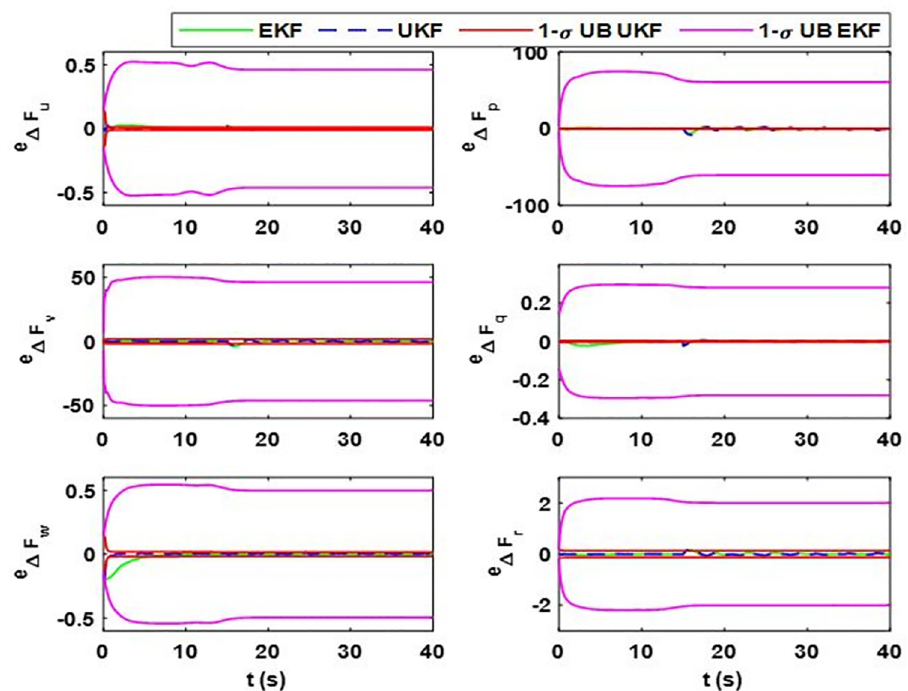
Fig 8. Estimation error and error bounds for lumped uncertainty vector showing the error and sigma bounds corresponding to (i) Δ F